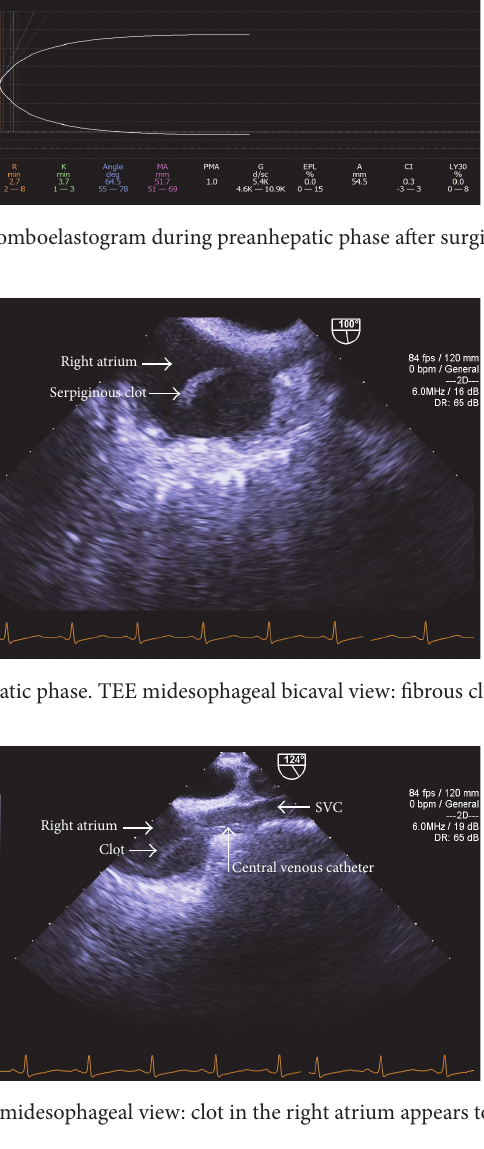
according to institutional protocol. All baseline